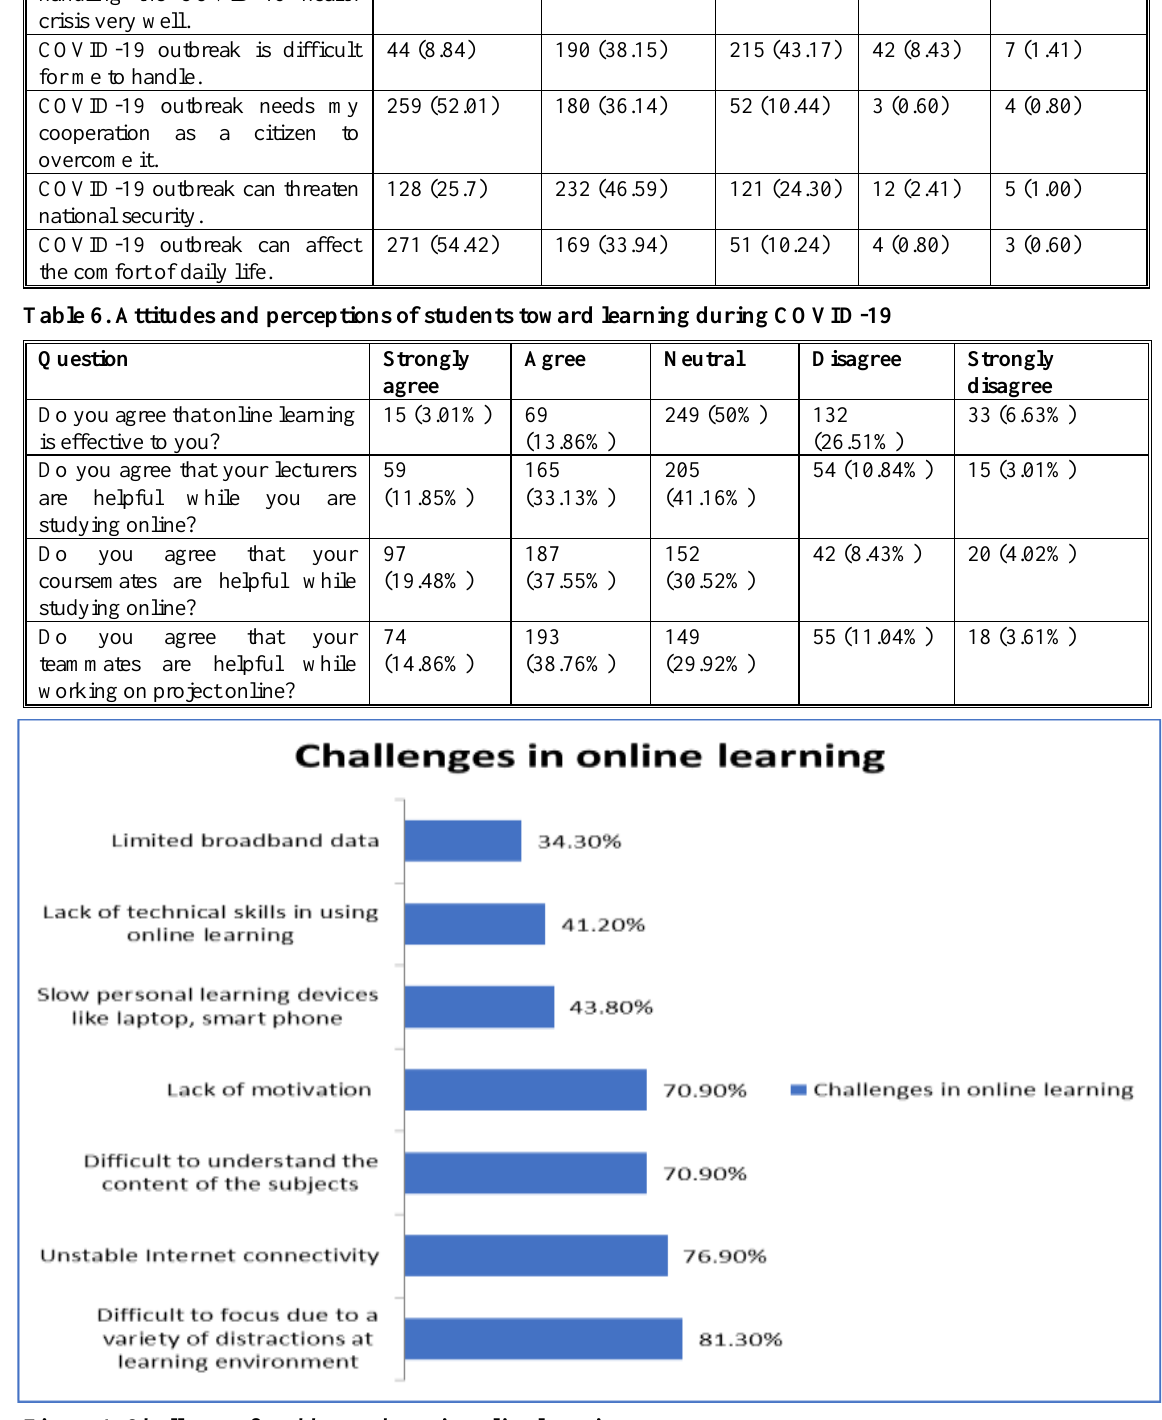
Figure 1. Challenges faced by students in online